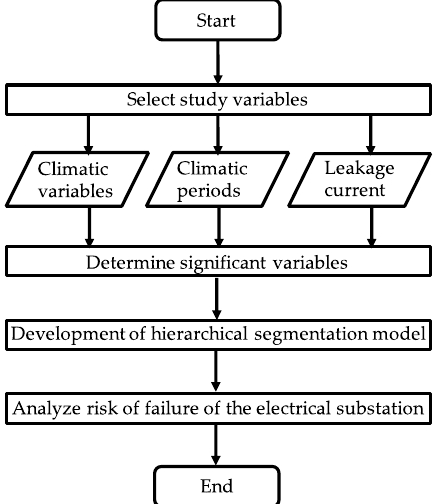
Figure 2. Method for analysing the risk of failure of HV insulators leading to substation failure [42].